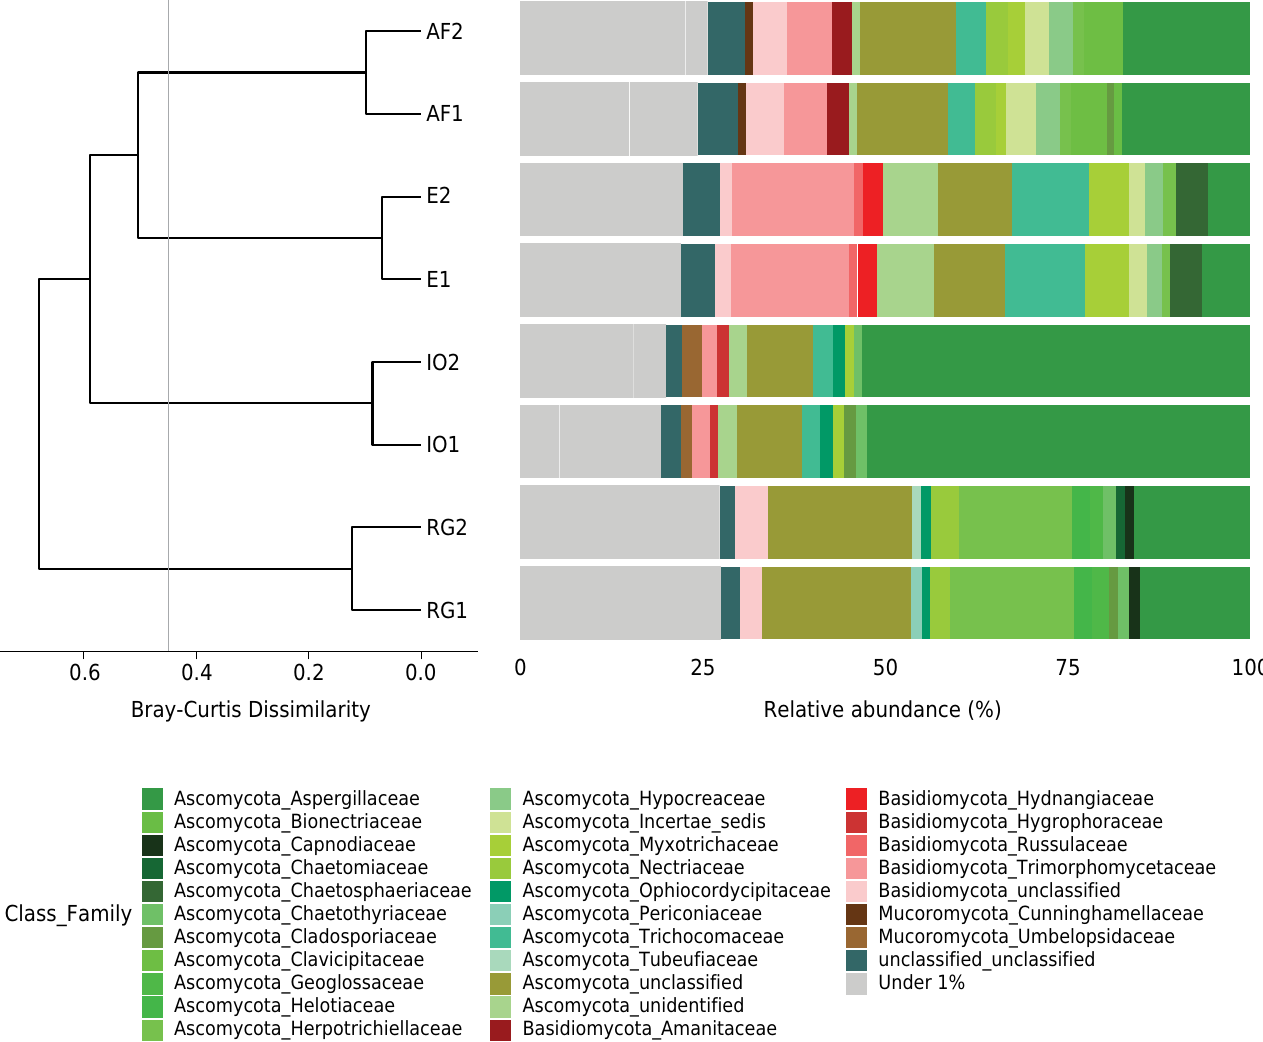
Figure 5. Fungal taxonomic community composition (family level) in all four vegetation types. UPGMA clustering formed four groups with greater than 45 % dissimilarity. Under 1 % represents all families with <1 % relative abundance. AF: Atlantic Forest; E: eucalyptus; IO: Iron outcrops; RG: rehabilitated area with